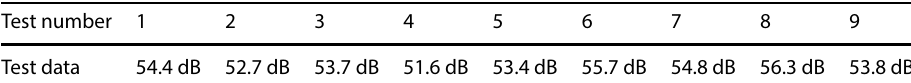
Table 2 Interior A-weighted noise